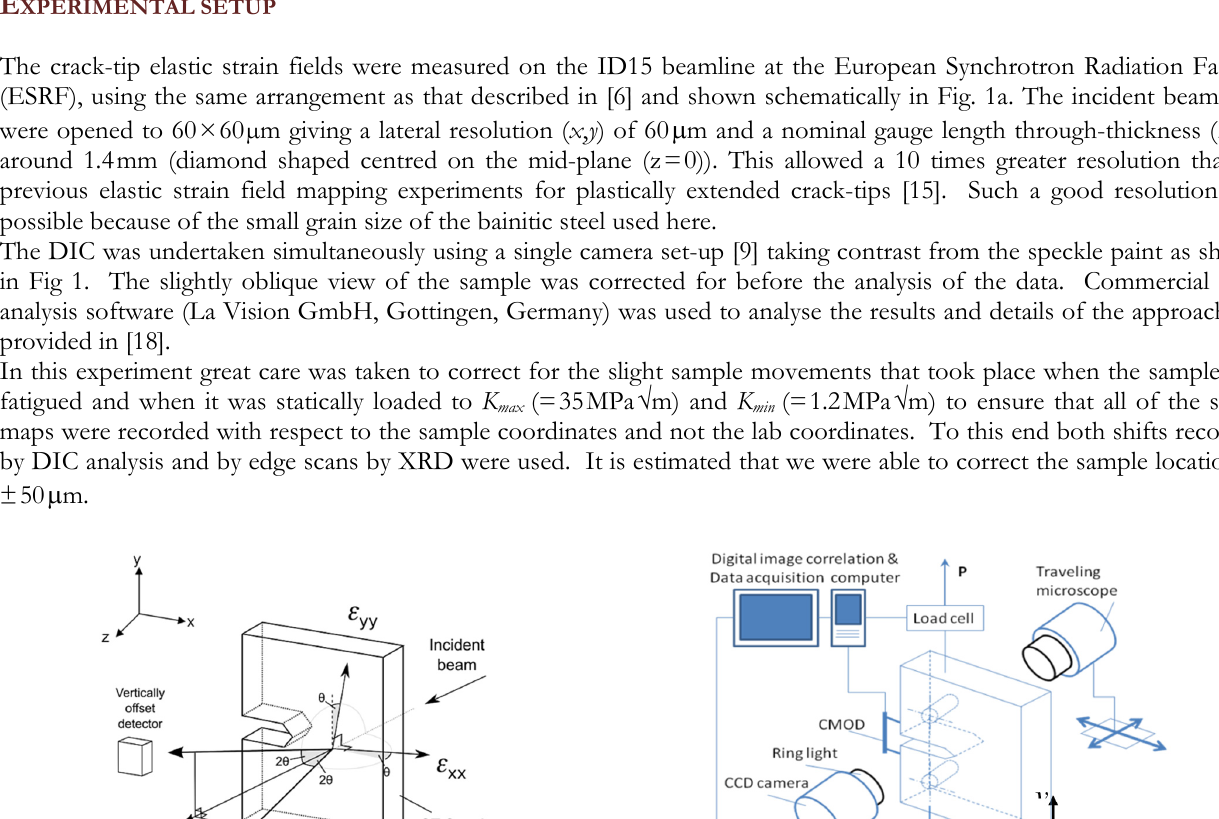
E XPERIMENTAL SETUP